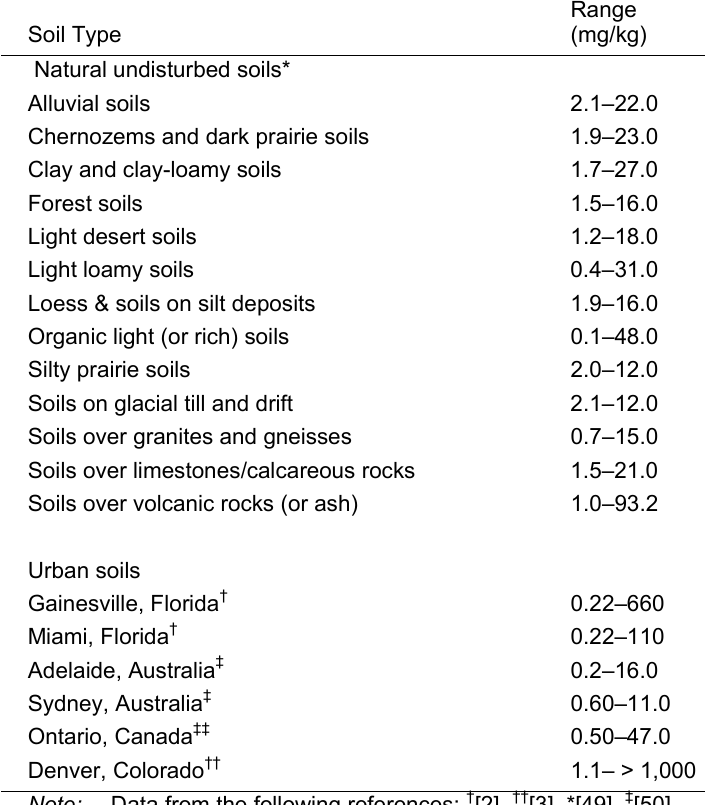
General Ranges of Arsenic Concentrations in Different Types of